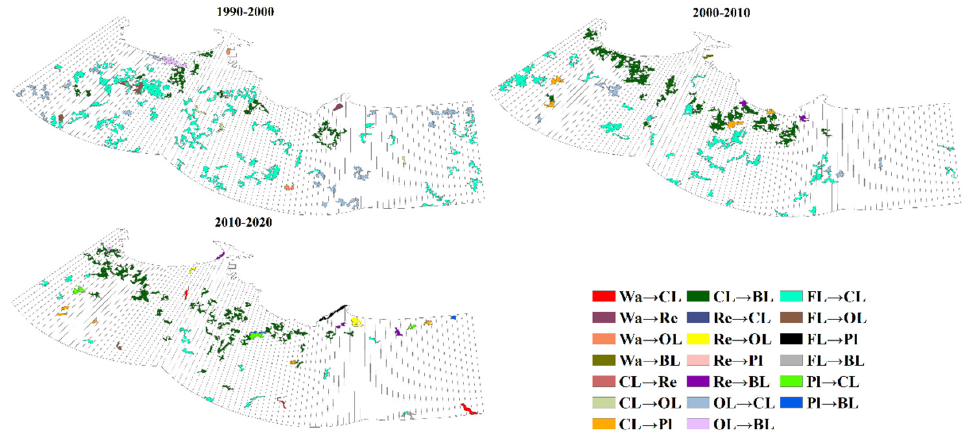
Figure 5. Schematic diagram of the LUT sequence samples in the Yantai coastal zone (BL: building land, Wa: waters, CL: cultivated land, GP: garden plot, FL: forestland, OL: other land and AS: aquaculture and salt field).